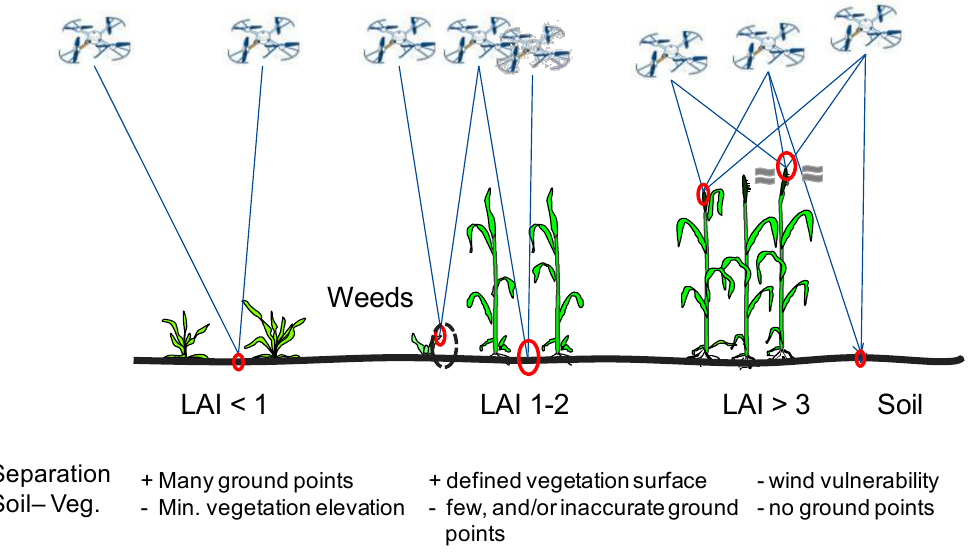
Figure 1. Possibilities and problems of UAS based photogrammetry for the derivation of crop surface models